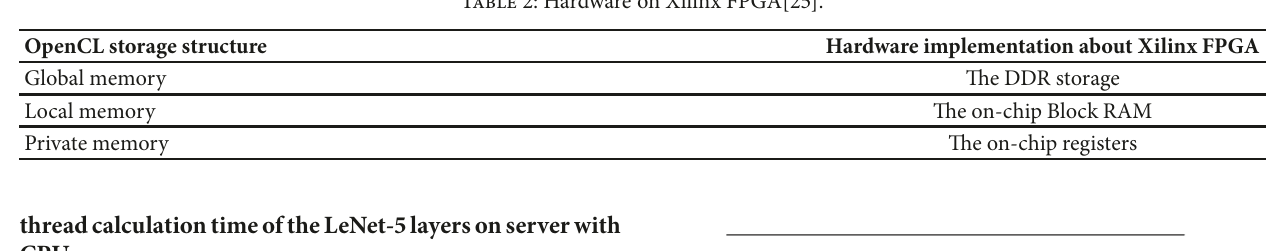
Table 2: Hardware on Xilinx